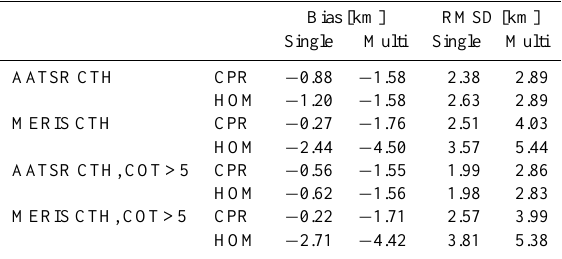
Table 1. Resulting biases and root mean square deviation (RMSD) from the comparison between the FAME-C cloud-top heights and radar/lidar derived cloud-top heights. Presented separately for single-layer clouds (Single) and multi-layer clouds (Multi) as well as for FAME-C cloud-top heights retrieved using 1 homogeneous cloud layer (HOM) and the CPR vertical cloud profiles (CPRs). Re- sults are also shown for clouds with a mean cloud optical thickness larger than